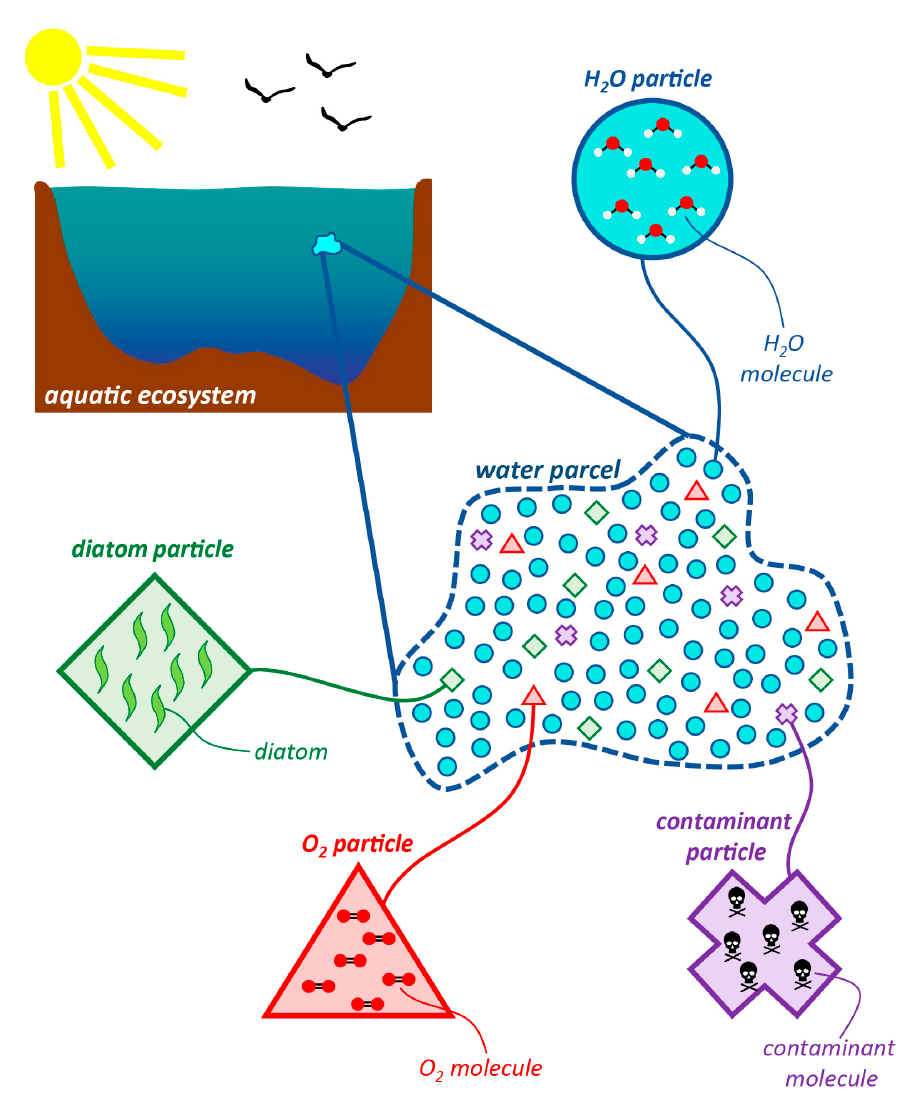
Figure 1. Cartoon depicting the relationships between water parcels, particles, and molecules, cells, etc., as defined herein. A water parcel is a mixture of particles, the most numerous of which are pure water particles. A particle is a material point at which many atoms, molecules, cells, etc., of an individual constituent or aggregate are concentrated. (Following Deleersnijder et al. [63]).